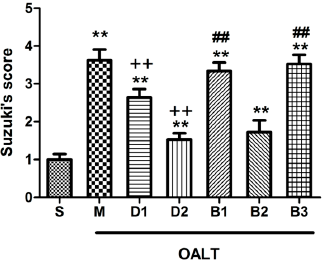
Figure 2. Quantification of histological scoring. The data are expressed as the means ± SD ( n = 8). ** p < 0.01, vs. group S; ++ p < 0.01, vs. group M; ## p < 0.01, vs. group D2.